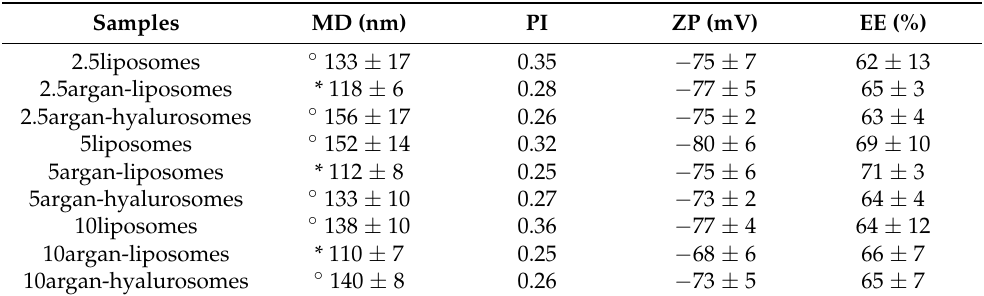
Table 1. Mean dimeter (MD), polydispersity index (PI), zeta Potential (ZP) and entrapment efficiency (EE) of liposomes, argan-liposomes and argan-hyalurosomes loading increasing amount of neem oil (2.5, 5, 10 mg/mL). Mean values ± standard deviations have been reported. Each symbol (*, ◦ ) indicates the same value p > 0.05.